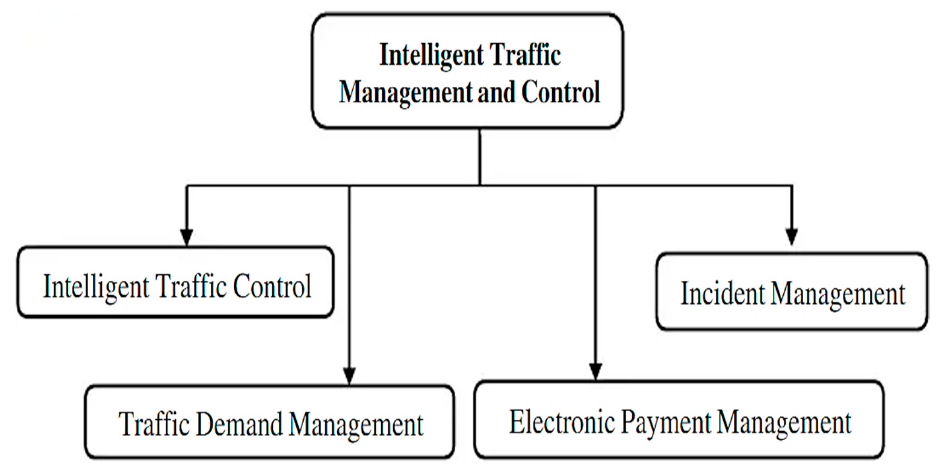
Figure 1. The component systems of the ITS